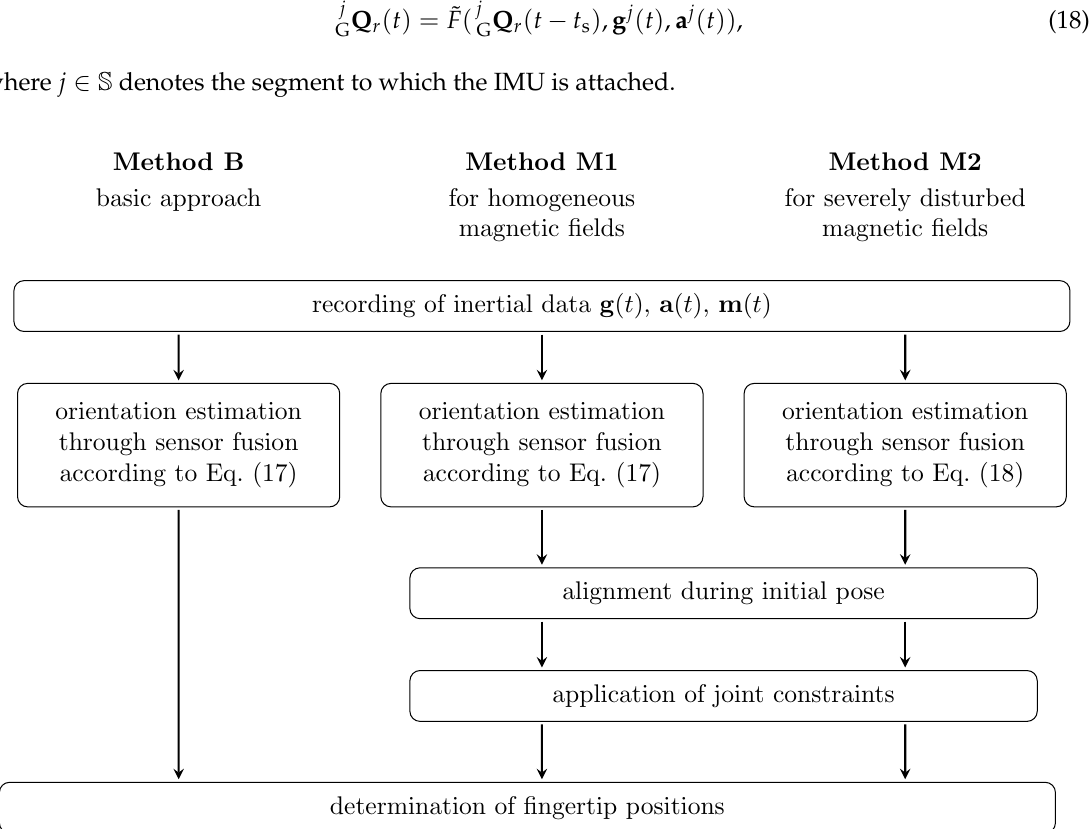
Figure 6. Summary of three proposed fingertip position estimation methods: the baseline method (B), and two advanced methods (M1 and M2). M1 and M2 exploit joint constraints to compensate errors